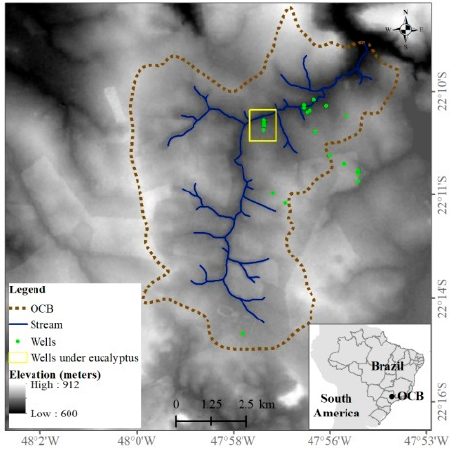
Figure 1. Study area location (Onça Creek Basin) with water-table monitoring network .